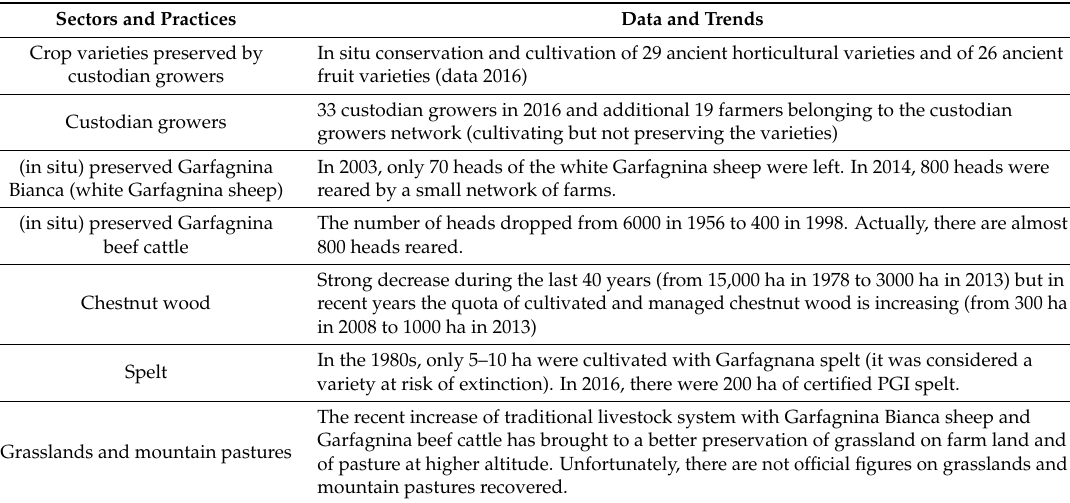
Table 3. Biodiversity and landscape: data and